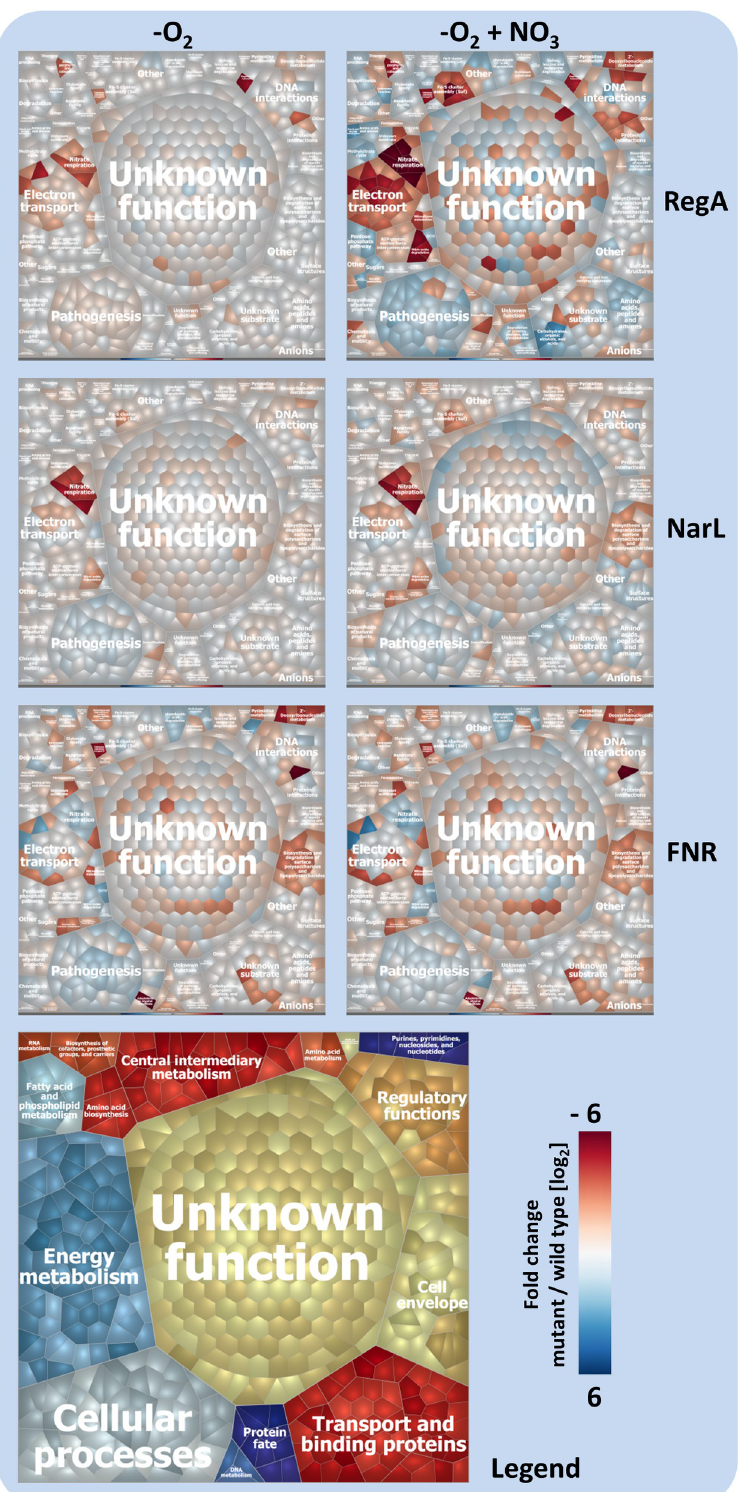
Fig 6. Voronoi treemap visualize RegA, NarL and FNR dependent gene expressions under hypoxia in absence (left) or presence of nitrate (right). Shown are the microarray based fold changes of the respective mutant strains versus the wild type. Pathways given in orange-brownish background are down-regulated, pathways in blue colours are